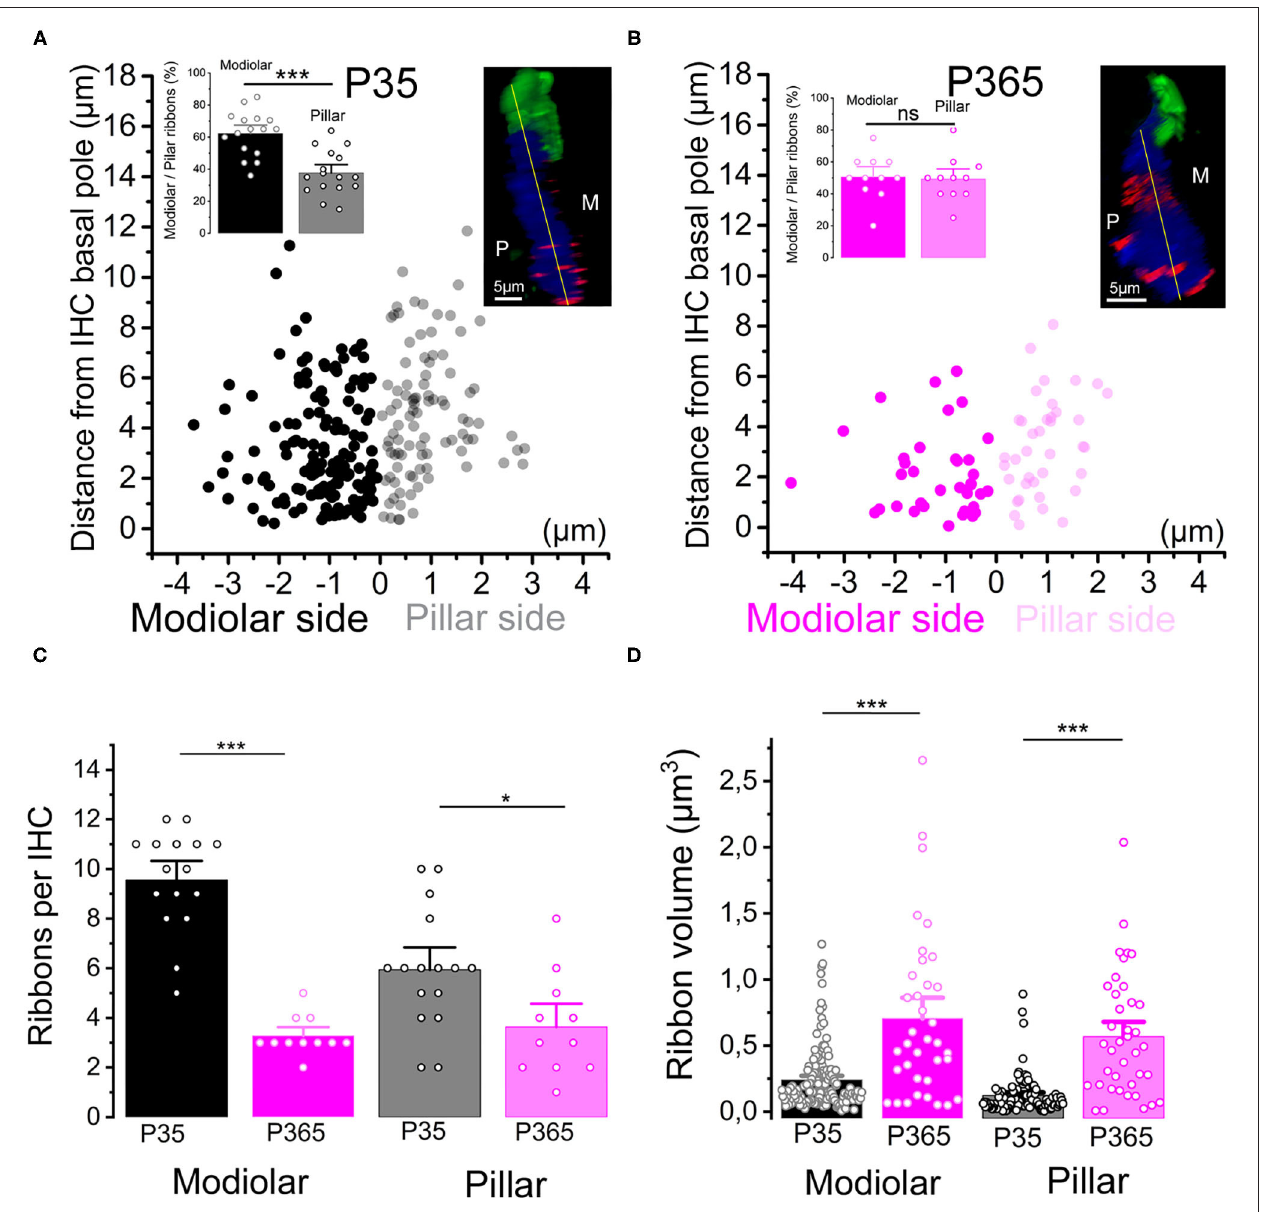
FIGURE 4 | Modiolar vs. pillar distribution of the synaptic ribbons with aging. (A,B) The distribution of IHC synaptic ribbons was splitted in two cell areas: P (pillar side) and M (Modiolar side). The two regions were determined using the K-means clustering method for each cell (see section Methods). The yellow lines in the inset confocal images was drawn to arbitrarily delineate the frontier between pillar and modiolar ribbons (green labeling F-actin, blue Otoferlin and red the synaptic ribbons). Note that in young P35 IHCs ( n = 16), synaptic ribbons are preferentially localized in the modiolar region (62.3 ± 3.5% vs. 37.7 ± 3.5; unpaired t -test p = 2.07 E − 5). In old P365 IHCs ( n = 11), the remaining ribbons equally distributed in the modiolar and pillar side (50.7 ± 4.0% vs. 49.3 ± 4.0%, unpaired t -test; p = 0.81). (C) Synaptic ribbons were significantly loss both at the modiolar side and pillar side. However, the loss was much more pronounced in the IHCs’ modiolar side (9.56 ± 0.5 ribbons ( n = 16 IHCs) vs. 3.27 ± 0.24 ribbons ( n = 11 IHCs); unpaired t -test p = 5.57 E − 10) and pillar (5.9 ± 0.6 ribbons vs. 3.6 ± 0.6 ribbons, unpaired t -test p = 0.016). (D) The increase in volume affected both modiolar [P35 = 0.24 ± 0.02 µ m 3 (153 ribbons) vs. P365 = 0.7 ± 0.1 µ m 3 (36 ribbons) unpaired t -test, p = 3.7 E − 11] and pillar [P35 = 0.12 ± 0.01 µ m 3 (95 ribbons) vs. P365 = 0.57 ± 0.07 µ m 3 (40 ribbons), unpaired t -test p = 7.5 E − 14] synaptic ribbons. This comparative analysis was performed in IHCs of the mid-cochlear region (encoding 8–16kHz). Asterisks indicate statistical difference with * p < 0.05 and *** p < 0.001.